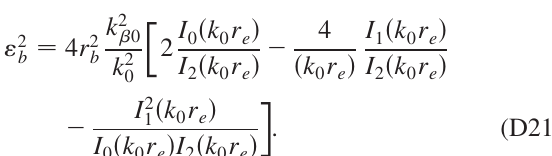
¼ (cid:5) 0 ¼ 0 : 9 ; 0 : 8 ; . . . ; 0 Þ(cid:6) n ð r Þ (cid:8) 3 (cid:5) 2 c 2 k 2 0 (cid:5) 0 b b r , and in (cid:5) 0 phase space is ? j . Values of (cid:3)=(cid:3) r and j x 0 corre- (cid:5) 0 0 ?